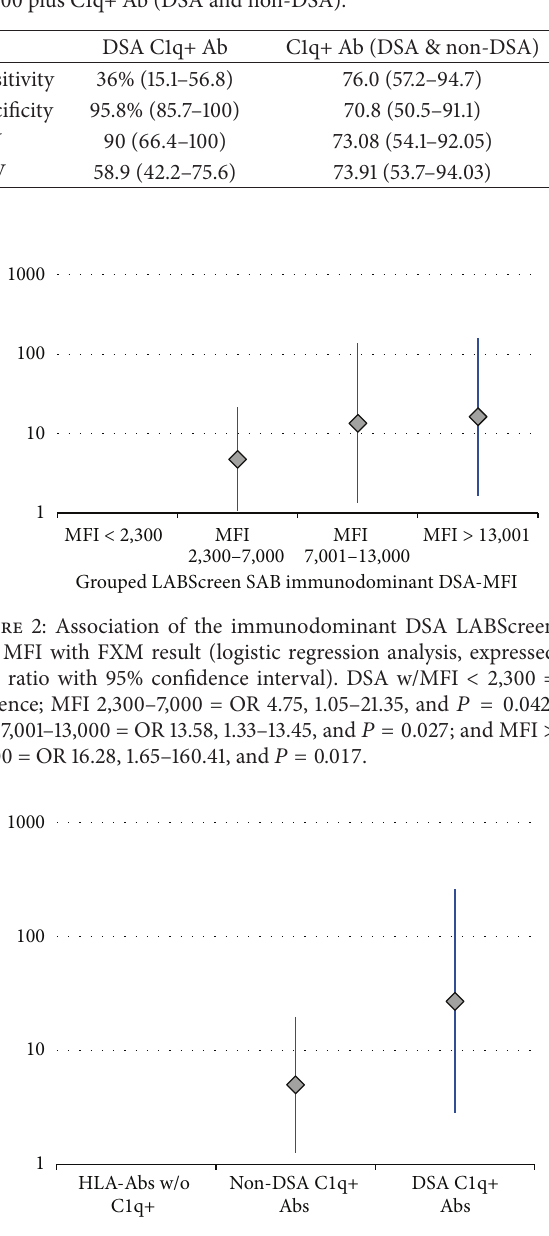
Figure 3: Association of C1q+ Ab (donor-specific and non-donor- specific) with positive FXM (logistic regression analysis, expressed odds ratio with 95% confidence interval). HLA-Ab w/o C1q+ = reference variable; non-DSA C1q+ Ab = OR 5, 1.27–19.68, and 𝑃 = 0.021 ; and DSA C1q+ Ab = OR 27, 2.80–259.56, and 𝑃 = 0.004 .